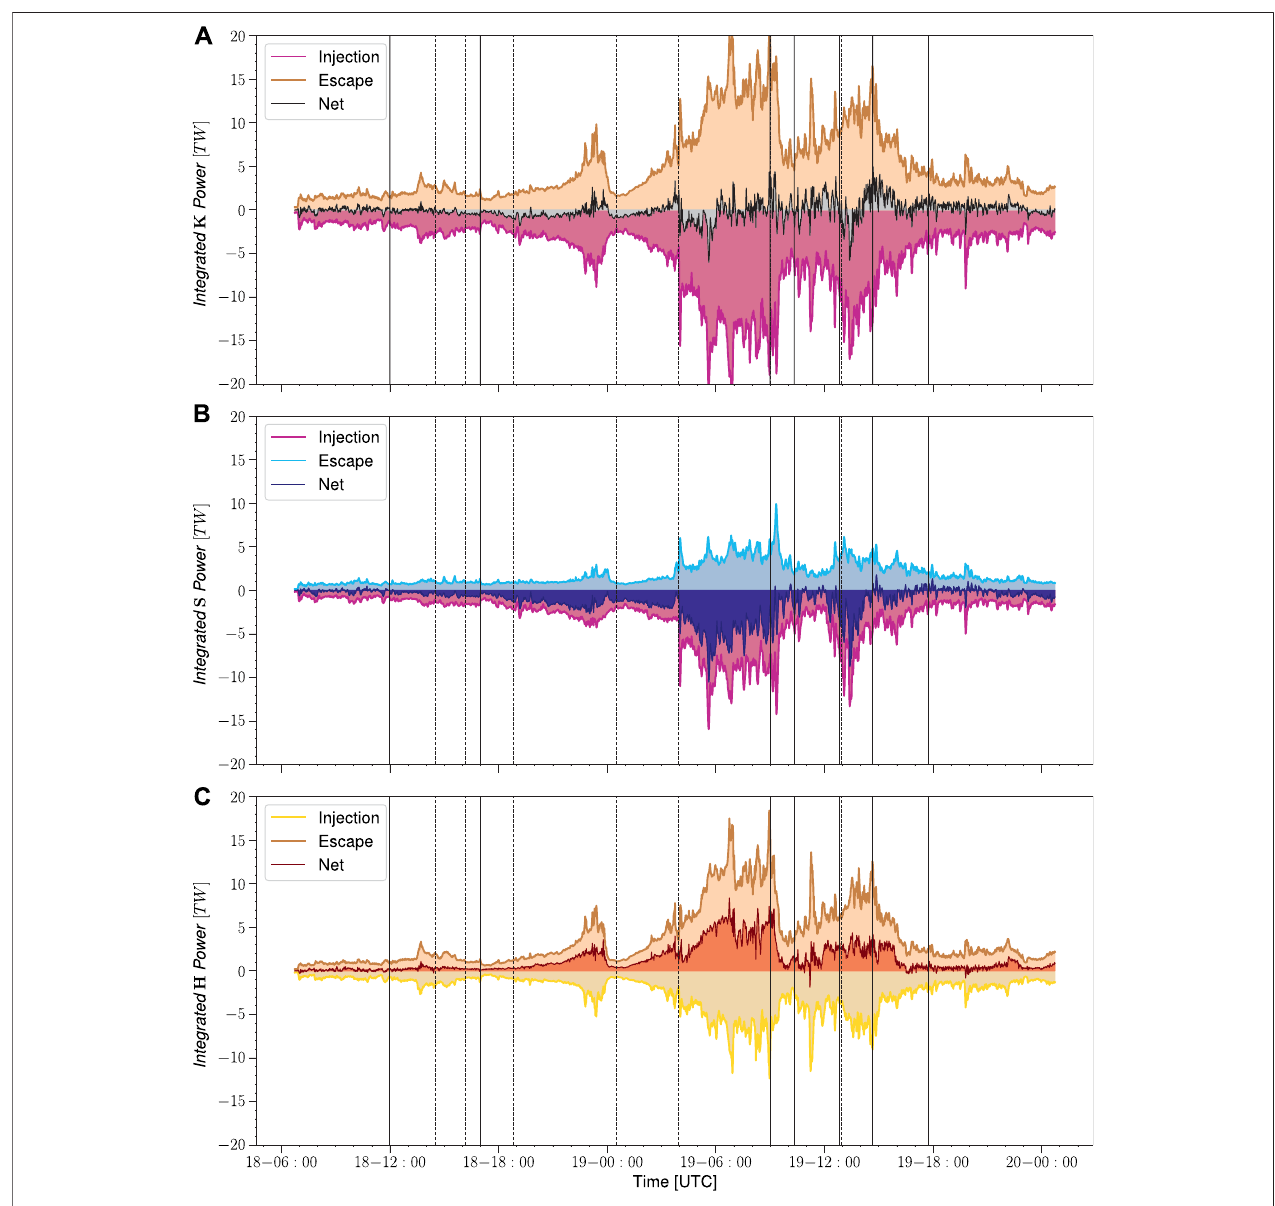
FIGURE 9 | Full surface energy fl ux integration breakdown by type, (A) : K (B) : S (C) : H ( Eq. 7 ).